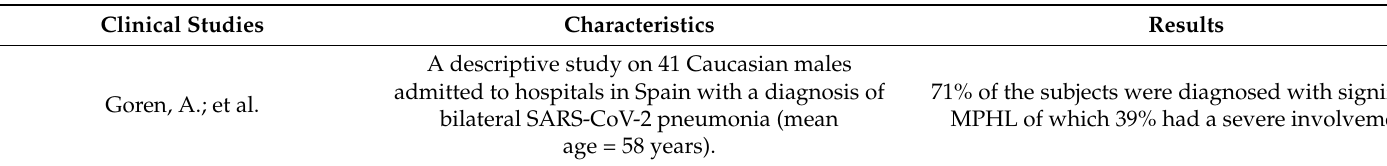
Table 1. Clinical studies on the relationship between hair loss and